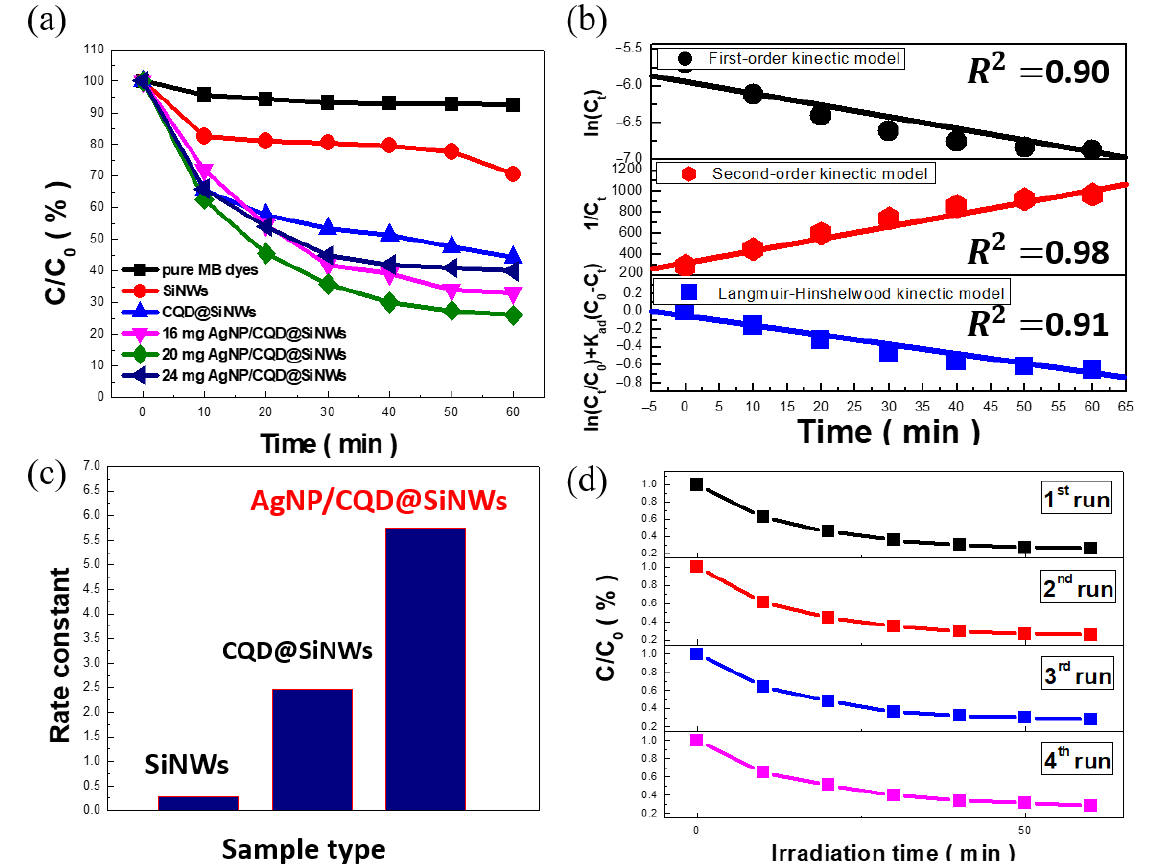
Figure 4. ( a ) Photodegradation results of MB dyes in the presence of SiNWs, CQD@SiNWs and CQD/AgNP@SiNWs with three various loading amounts of CQD/AgNP nanoparticles, respectively. ( b ) Kinetic investigations and ( c ) rate constant of MB degradation in the presence of CQD/AgNP@SiNWs (20 mg of CQD/AgNP loadings). ( d ) Cycling tests of CQD/AgNP@SiNW